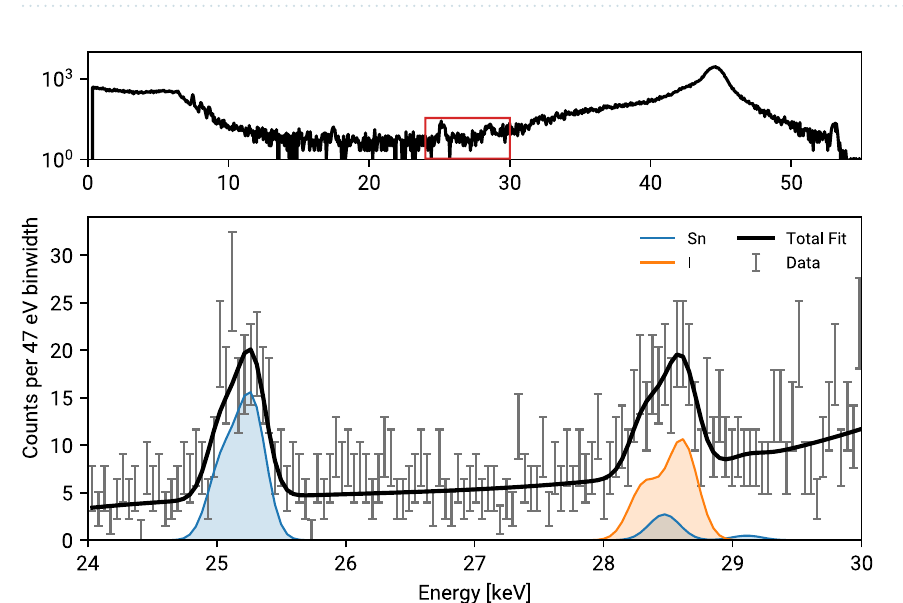
Figure 1. Thyroidal iodine mass maps of mouse M3 for 1 mm, 0.5 mm and 0.2 mm resolution with Z min = 1.6 ( a – c ) and Z min = 3 ( d – f ).